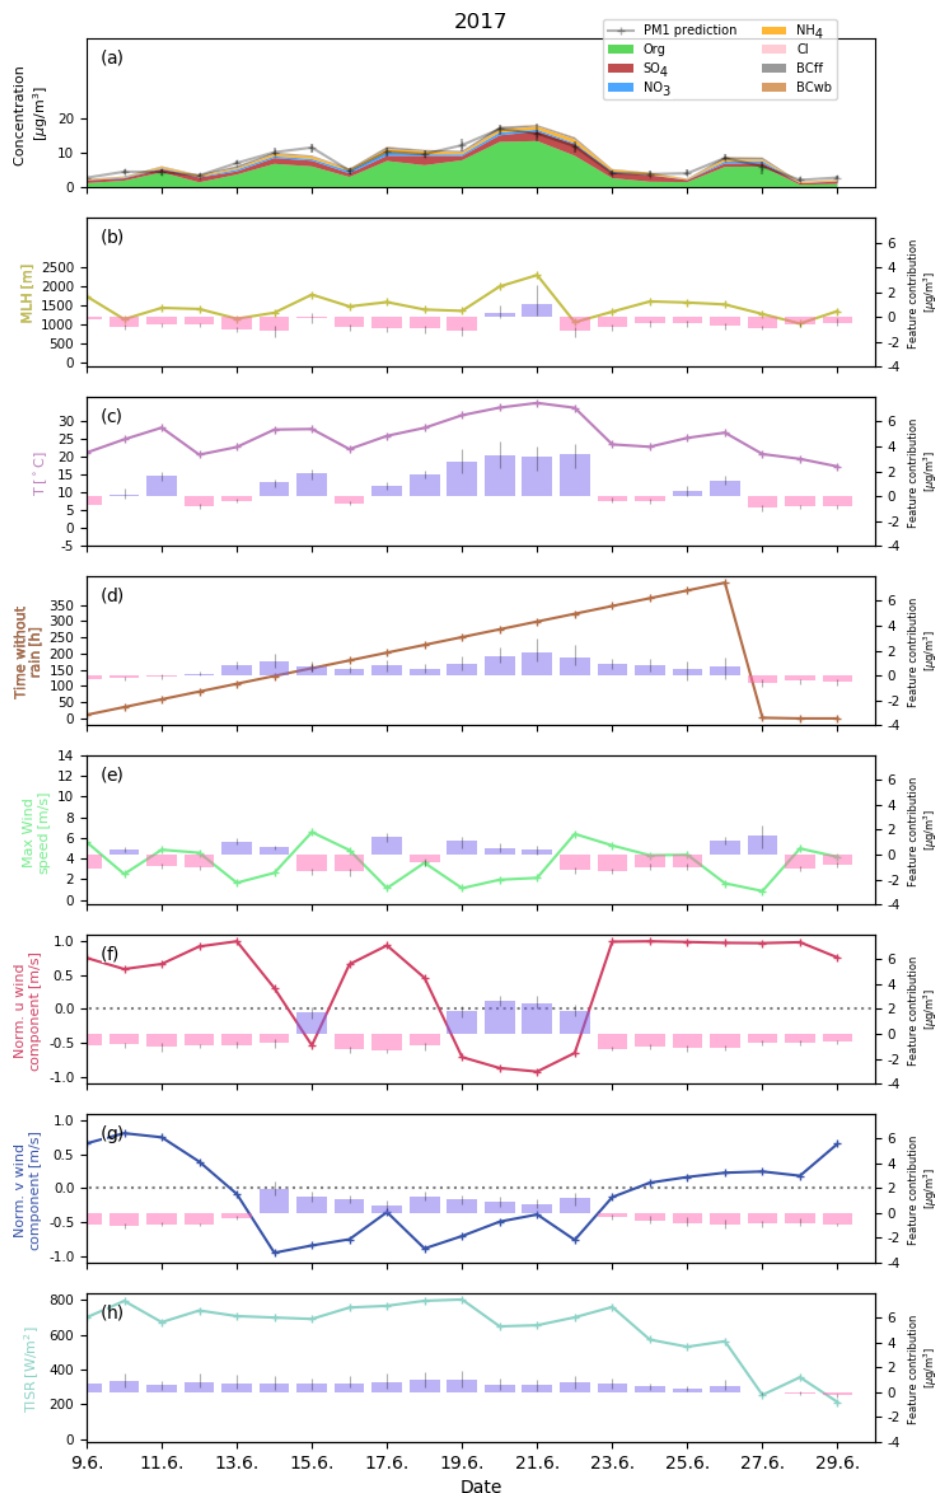
Figure 13. As Fig. 11 for an exemplary summer pollution episode in June 2017.